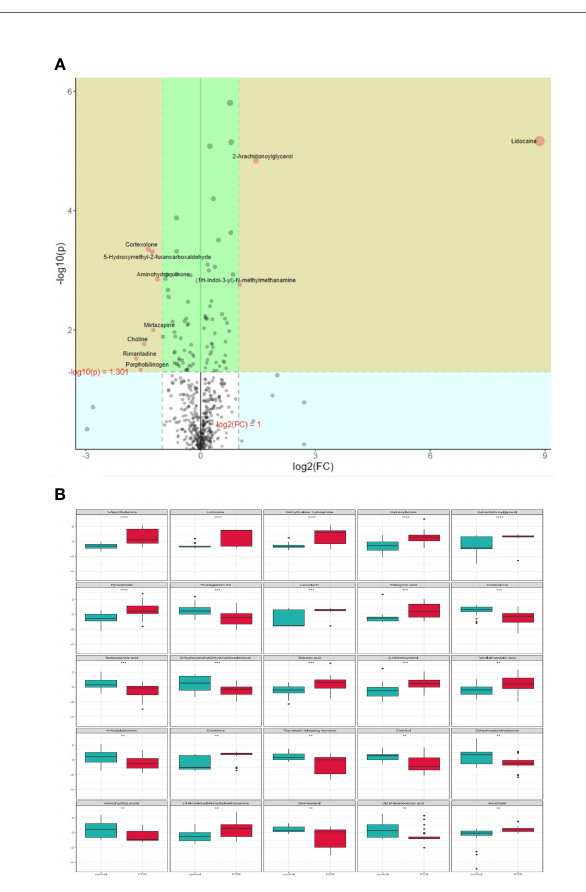
FIGURE 8 | Volcano features (A) and box diagram (B) of metabolite differences. **p < 0.01, ***p < 0.001, ****p < 0.0001.